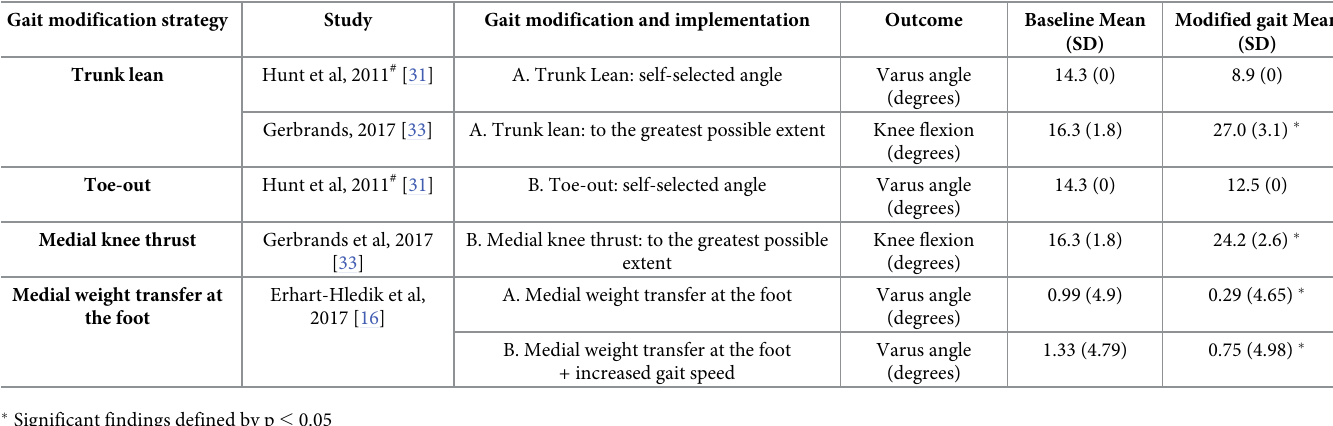
Table 5. Effects of gait modifications on the kinematics of the knee